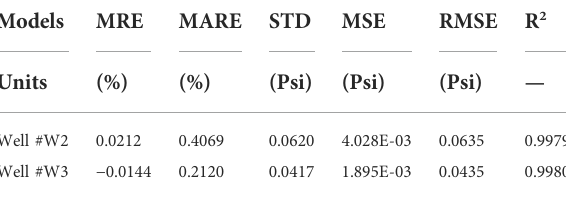
TABLE 8 Development and generalization of new robust hybrid machine learning LSSVM-PSO algorithm that structured